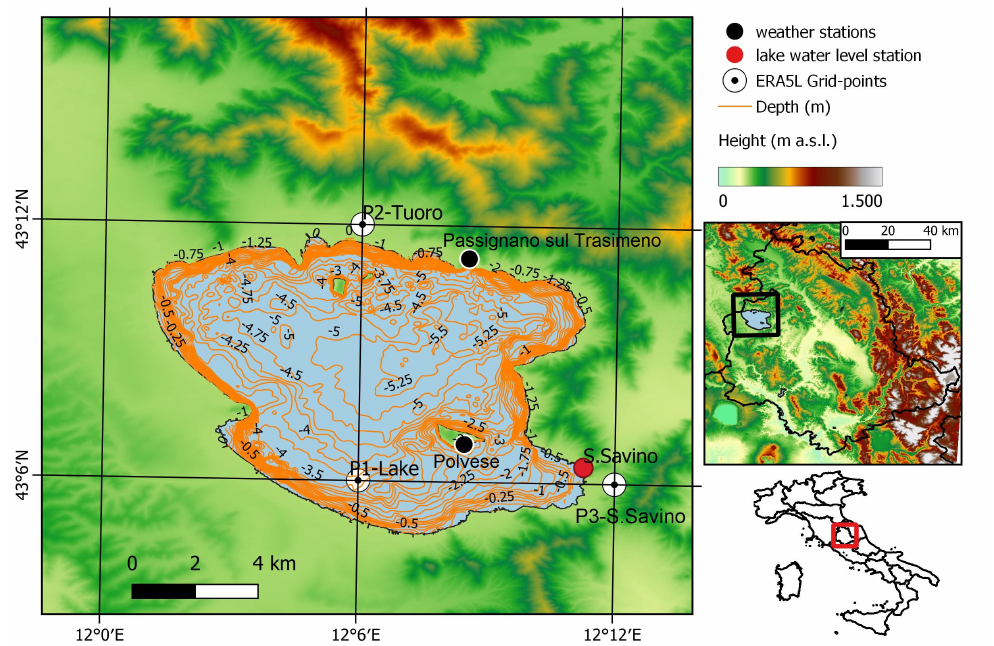
Figure 1. Map of the Trasimeno lake area and bathymetry with: ERA5L grid and points (P1-Lake, P2-Tuoro, and P3-S. Savino, indicated by white circles); the Umbria region weather stations measuring temperature and precipitation (Polvese, and Passignano sul Trasimeno, indicated by black circles), and the lake level measurement station (S. Savino, indicated by a red